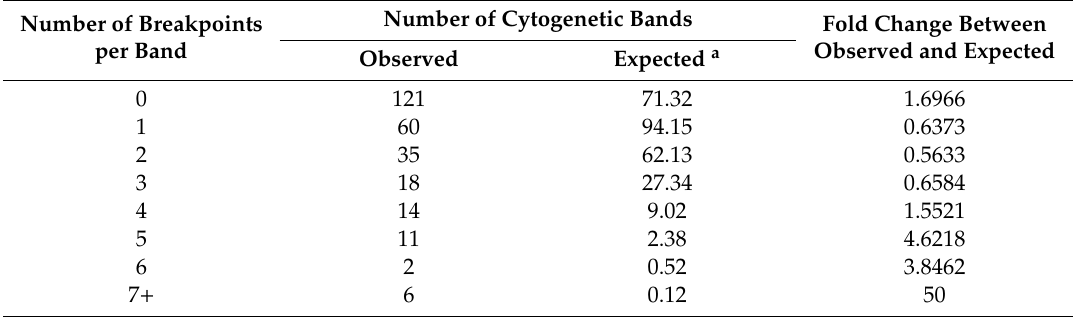
Table 4. Distribution of cytogenetic bands that possess a given number of translocation breakpoints.